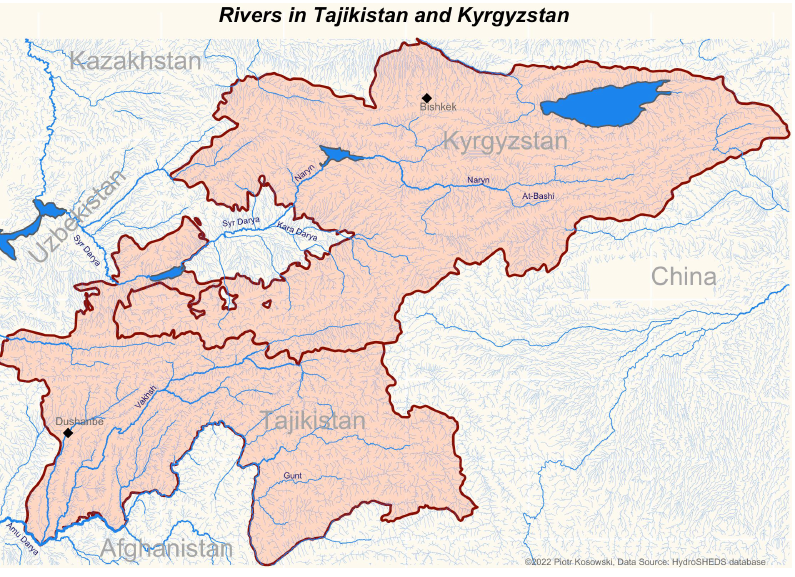
Figure 1. Rivers in Tajikistan and Kyrgyzstan.